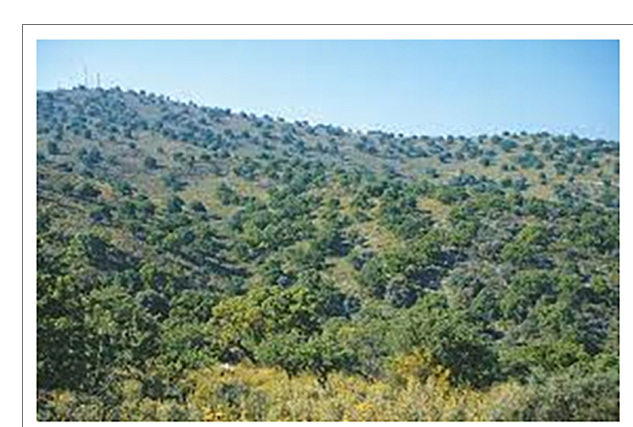
FIGURE 3 | Reproduced with permission. Image licensed under the Creative Commons Public Domain CC0 1.0 Universal, available at https://es.m.wikipedia.org/ wiki/Archivo:Krasnoyarsk_Taiga.jpg.